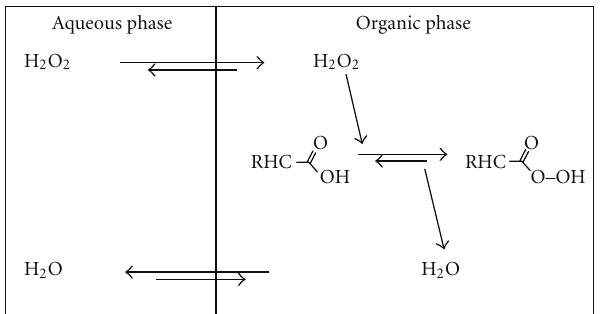
Figure 2: Schematic presentation of the mass transport of hydrogen peroxide and water in an organic-water biphasic system.